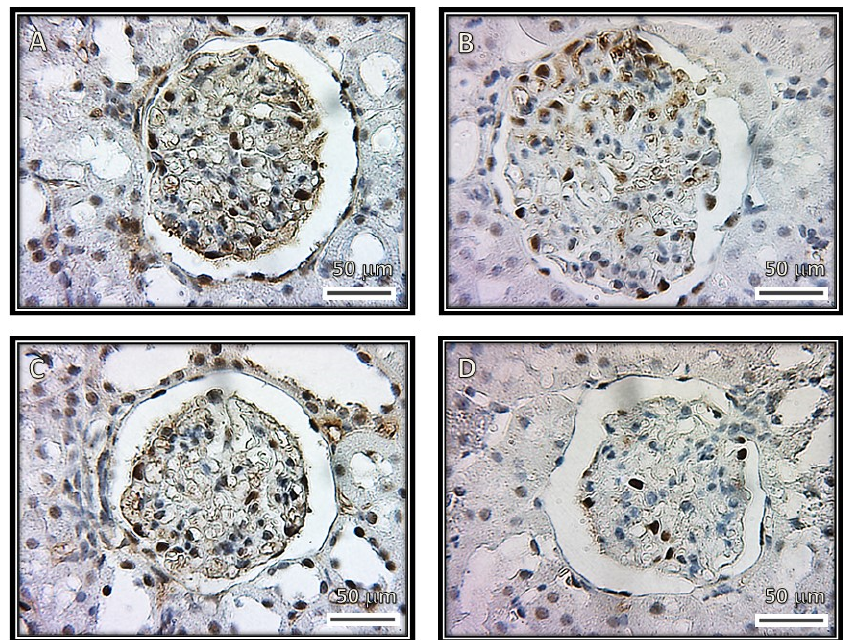
Figure 6. Representative immunohistochemistry of rat renal cortex with the ripening marker WT1.